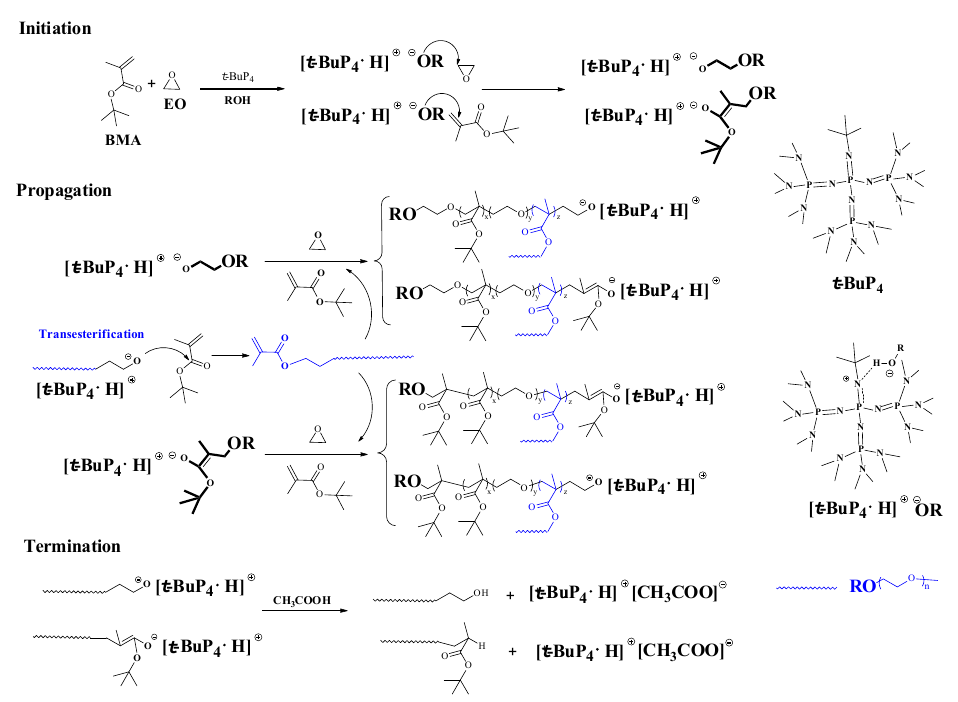
Figure 3. ( A ) TGA curves of PEO, PBMA and their copolymer products, ( B ) ionic conductivity with different EO:Li + of BMA 38 - co -EO- co - b PEO 12 .